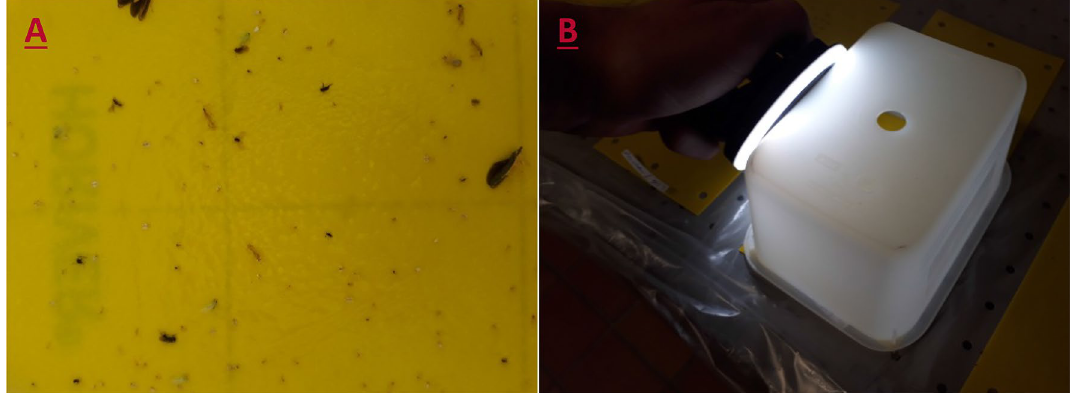
Figure 4. ( A ) Example of a yellow sticky trap that was taken weekly in the greenhouse chambers. This figure illustrates the realistic diversity of species present in the traps, including aphids, cicadellids, and Diptera. ( B ) To reduce light reflections on the YST surface, a plastic box and a ring light were used to capture the